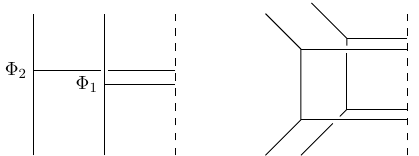
Figure 7 . DIM representation web for a D 1 quiver (left) and the corresponding ( p; q )-brane web diagram for a U(2) gauge group